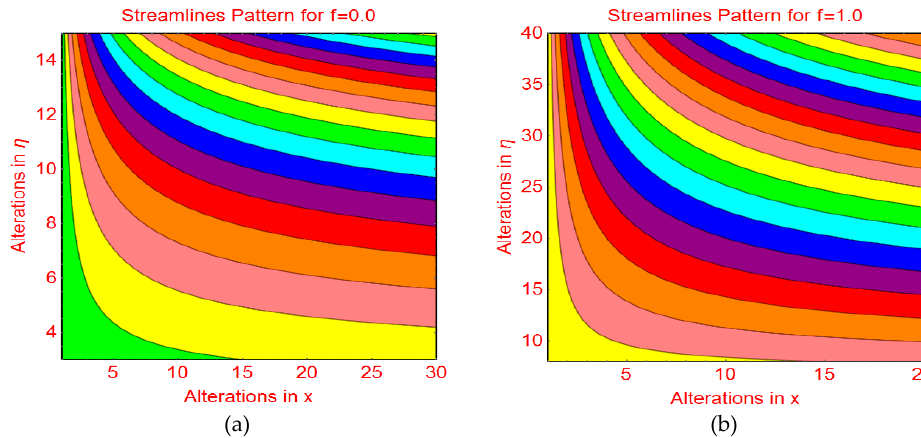
Figure 8. E ff ects of φ on the temperature profile β ( η ) ( a ) f1 = 1.0 ( b ) f1 = − 1.0. Figure 8. Effects of 𝜙 on the temperature profile 𝛽(𝜂) ( a ) 𝑓1 = 1.0 ( b ) 𝑓1 = −1.0